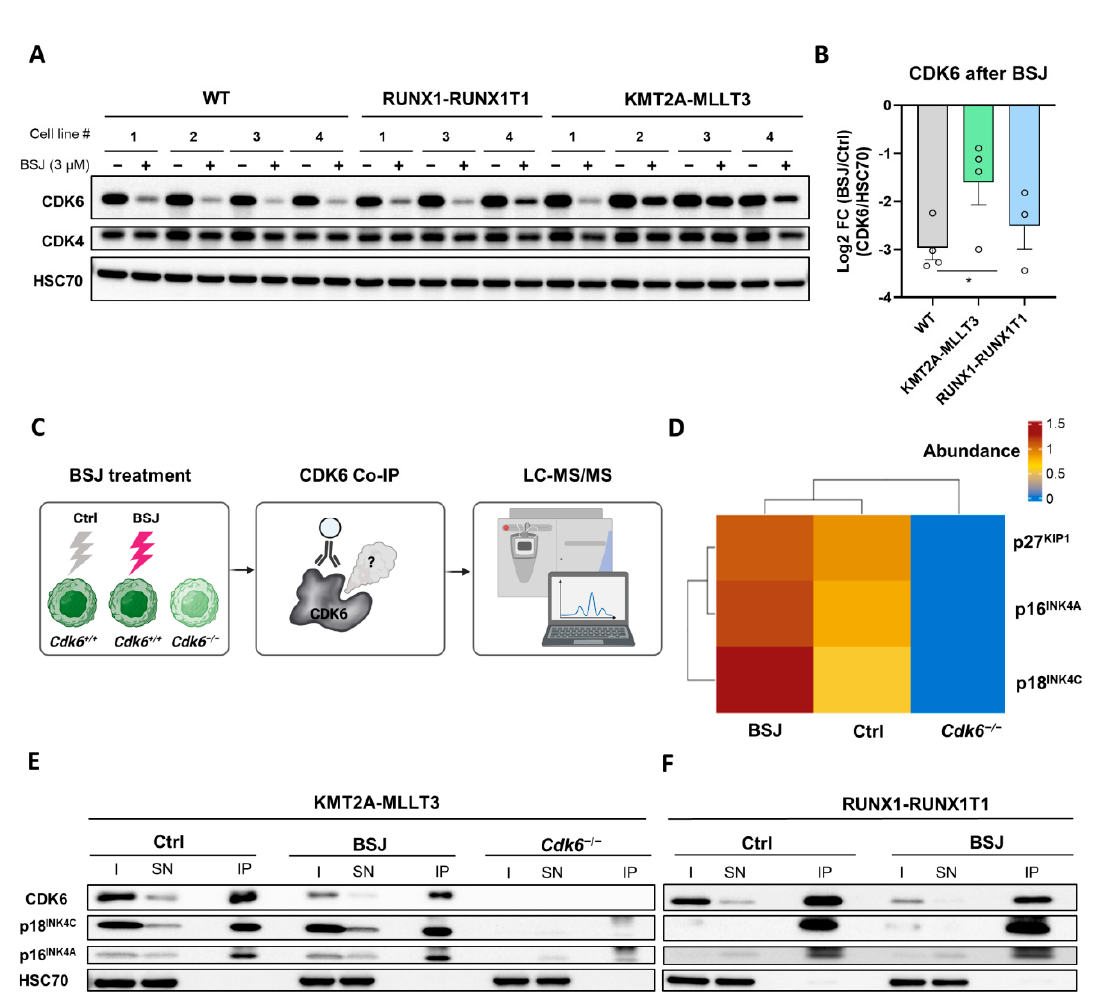
Figure 3. CDK6-INK4 complexes were enriched after BSJ treatment. ( A ) The immunoblot for